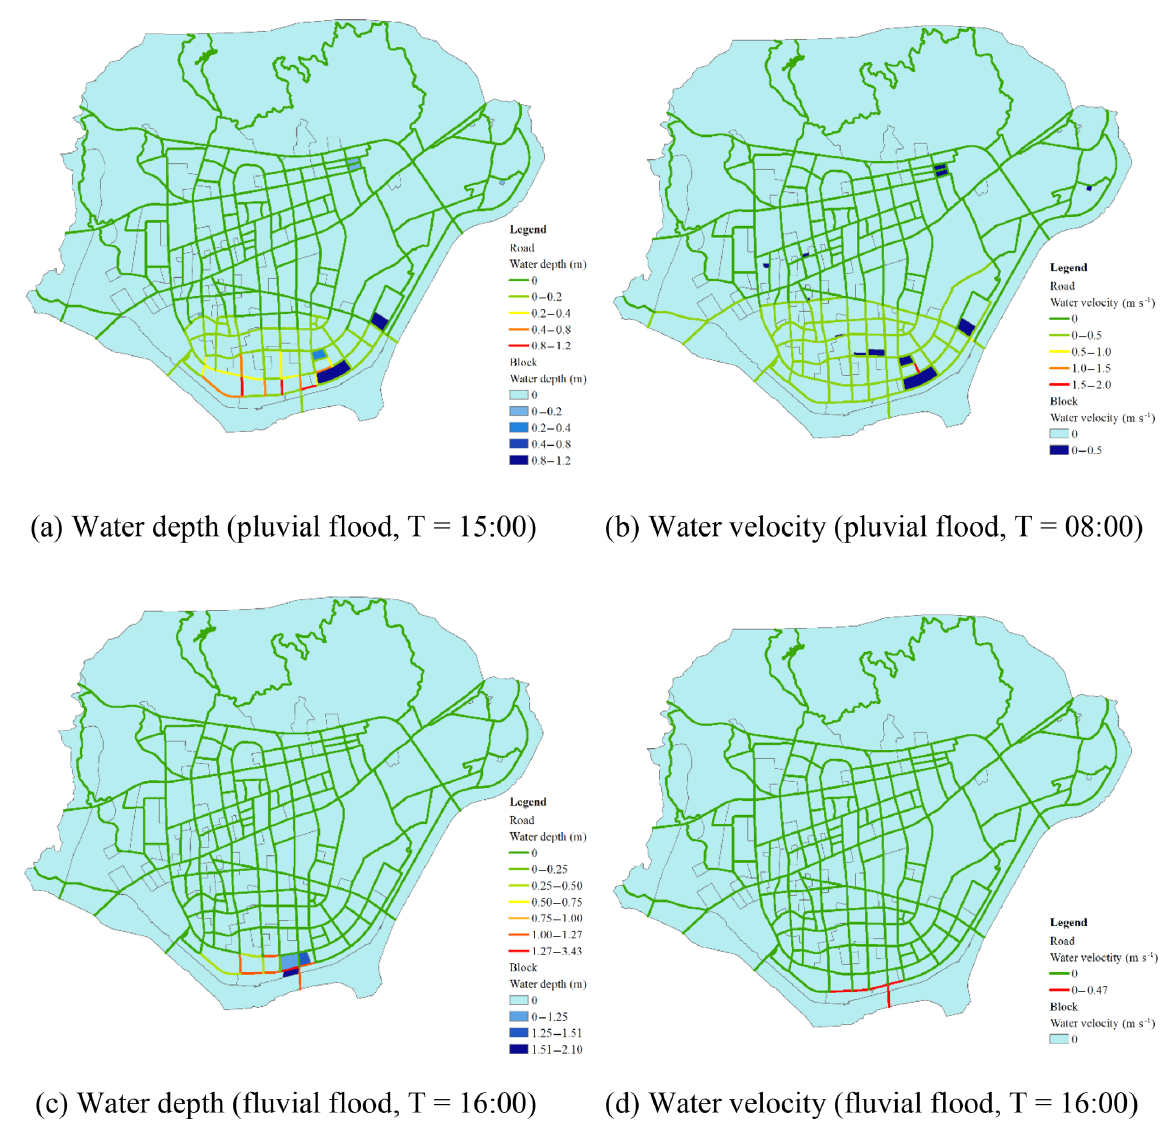
Figure 9. Map of accumulated water depths and velocities. T means time here.